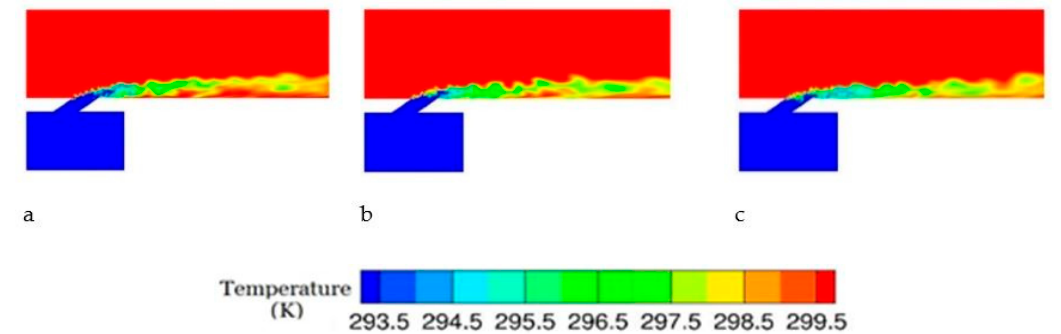
Figure 26. ( a ) The instantaneous temperature contour for the central cross section using the FLUENT, LES, Smagorinsky–Lilly model for M = 0.5, 1072 Hz ( b ). [28] The instantaneous temperature contour for the central cross section using the FLUENT, LES, Smagorinsky–Lilly model for M = 0.5, 1608 Hz ( c ). [28] The instantaneous temperature contour for the central cross section using the FLUENT,